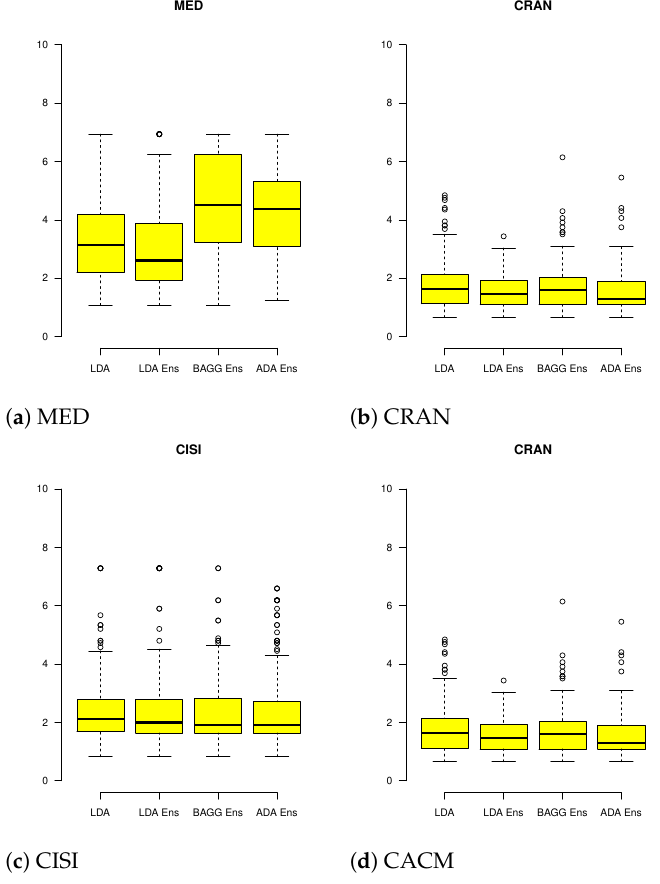
Figure 2. IDF distributions of each LDA method across the datasets used in this